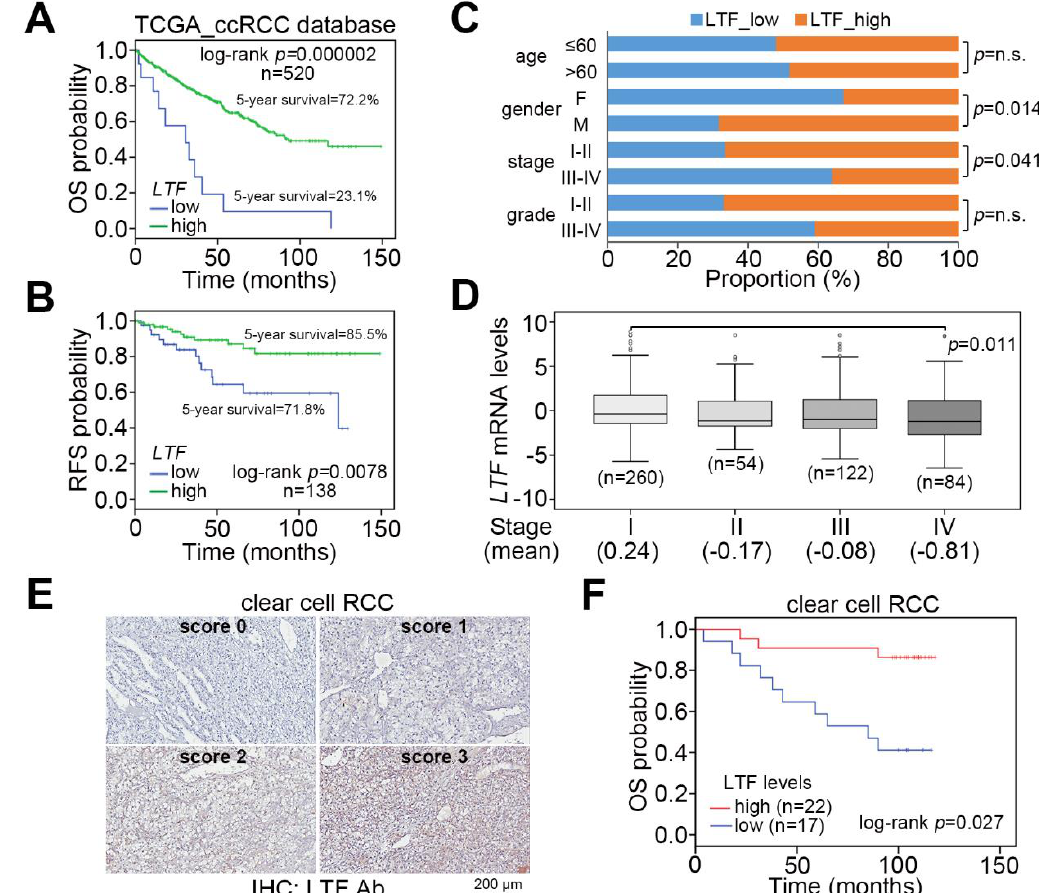
Figure 2. LTF downregulation correlates with cancer progression in ccRCC. ( A , B ) Kaplan–Meier analyses at a maximal risk condition of overall survival (OS, ( A )) and recurrence-free survival (RFS, ( B )) probability in TCGA ccRCC patients with low ( n = 13 for OS, n = 39 for RFS) and high ( n = 507 for OS, n = 99 for RFS) levels of LTF gene expression. ( C ) Histogram displays the results of a Chi-square test for the indicated LTF mRNA levels and pathologic variables including age, sex, stage, and grade obtained from the TCGA ccRCC database. The symbol “n.s.” denotes a nonsignificant result. ( D ) Boxplot represents the transcriptional profile of LTF gene expression in TCGA ccRCC samples with different pathological stages. The significant differences were analyzed by one-way ANOVA with Tukey’s test. ( E ) The IHC results for the LTF protein intensities ranged from a score of 0 to a score of 3. ( F ) Kaplan–Meier analysis of low (scores 0 and 1) and high (scores 2 and 3) LTF protein levels from the IHC analysis of tumors from 39 ccRCC patients.